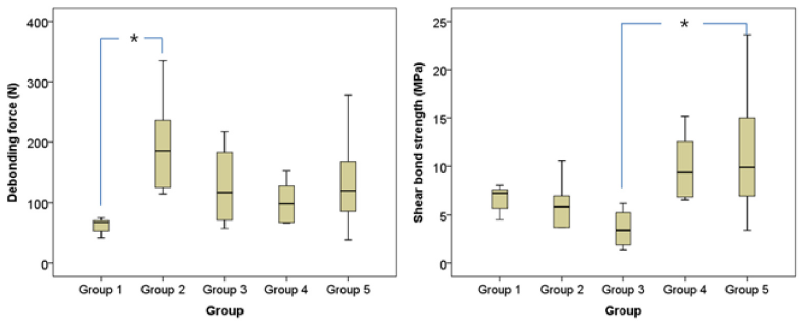
Fig 4. Box slot of debonding force and shear bonding strength. The bottom and top of the boxes are the 25 th and 75 th percentile respectively of debonding forces and SBS for each group. The band near the middle of the box denotes the median. Upper and lower horizontal lines outside the box represent maximum and minimum values within a 1.5 interquartile range. The superscripts indicate differences in debonding forces and shear bond strength, according to Tukey’s HSD test, at P = 0.05. Group 1, preadjusted bracket; Group 2, Harmony; Group 3, Incognito; Group 4, Insignia; Group 5,